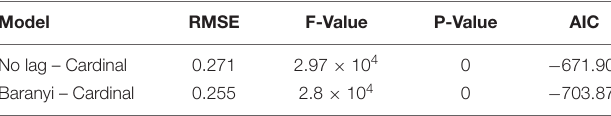
TABLE 2 | One-step analysis results of WT and (cid:49) sdiA mutant strains.